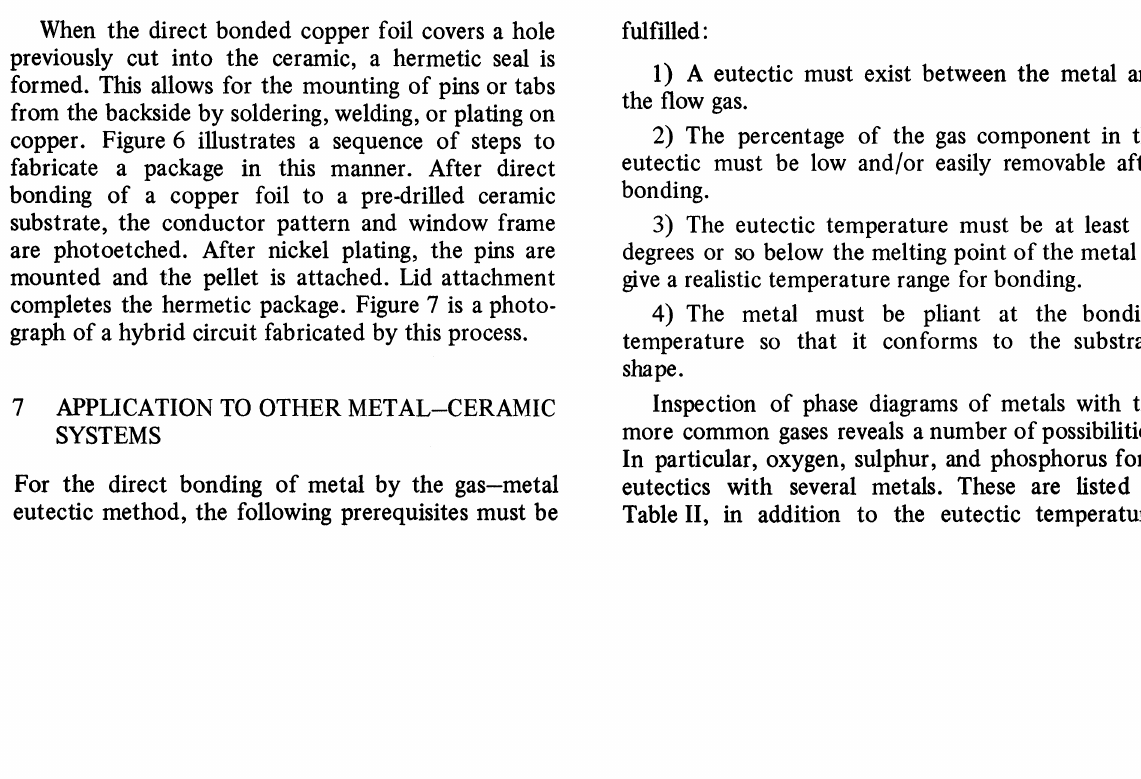
FLY WIRE, BEAM LEAO$, SPIDER BONDS, OR FLIP-CHIP BUMPS PROCESS STEPS TO FABRICATE ELECTRONIC PACKAGE BY DIRECT COPPER BO!DING PICESS FIGURE 5 Process steps to fabricate electronic package by direct bonding